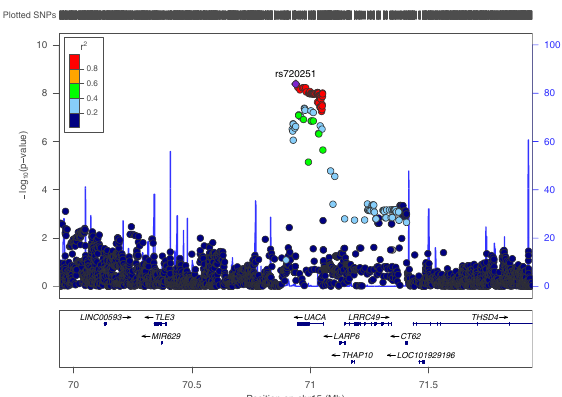
Fig. 2 Locuszoom plot for the UACA locus in GWAS of OS within the Pathways European population when including patients taking Par-4 dependent chemotherapies. The 2 Mb region centered on the lead variant rs720251 was plotted. LD structure was based on 1000 genomes EUR population (Nov